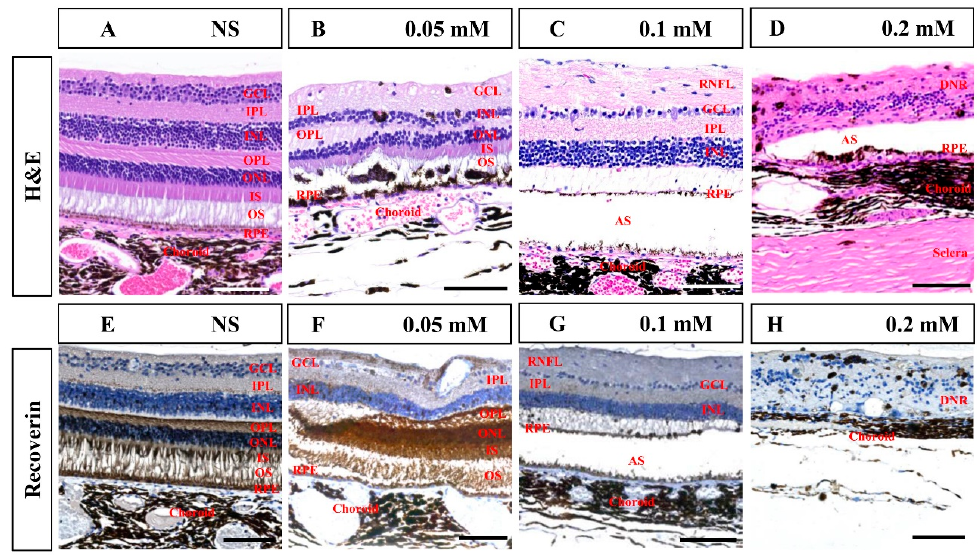
Figure 7. Hematoxylin and eosin (H&E) and immunohistochemistry staining of the retina in monkeys 7 months after SNP SI. ( A – D ) H&E staining in the NS group and SNP groups with three different doses. ( E – H ) Immunohistochemistry staining showed that recoverin-positive photoreceptor cells showed no remarkable changes in the NS group, were partially lost in the 0.05 mM group, almost entirely disappeared in the 0.1 mM group, and completely disappeared in the 0.2 mM group. GCL: ganglion cell layer; IPL: inner plexiform layer; INL: inner nuclear layer; OPL: outer plexiform layer; ONL: outer nuclear layer; IS: inner segment; OS: outer segment; RPE: retinal pigment epithelium; RNFL: retinal nerve fiber layer; AS: artifact space caused by tissue process; DNR: degenerated neural retina. Scale bar: 100 μ M.